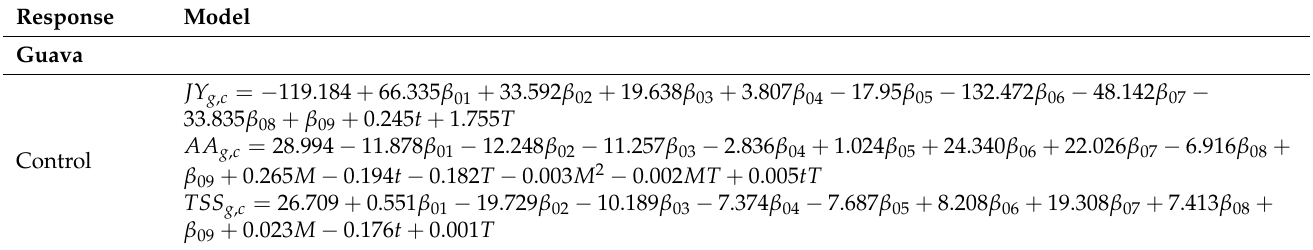
Table 3. Improved models for percentage change of juice yield, AA, and TSS